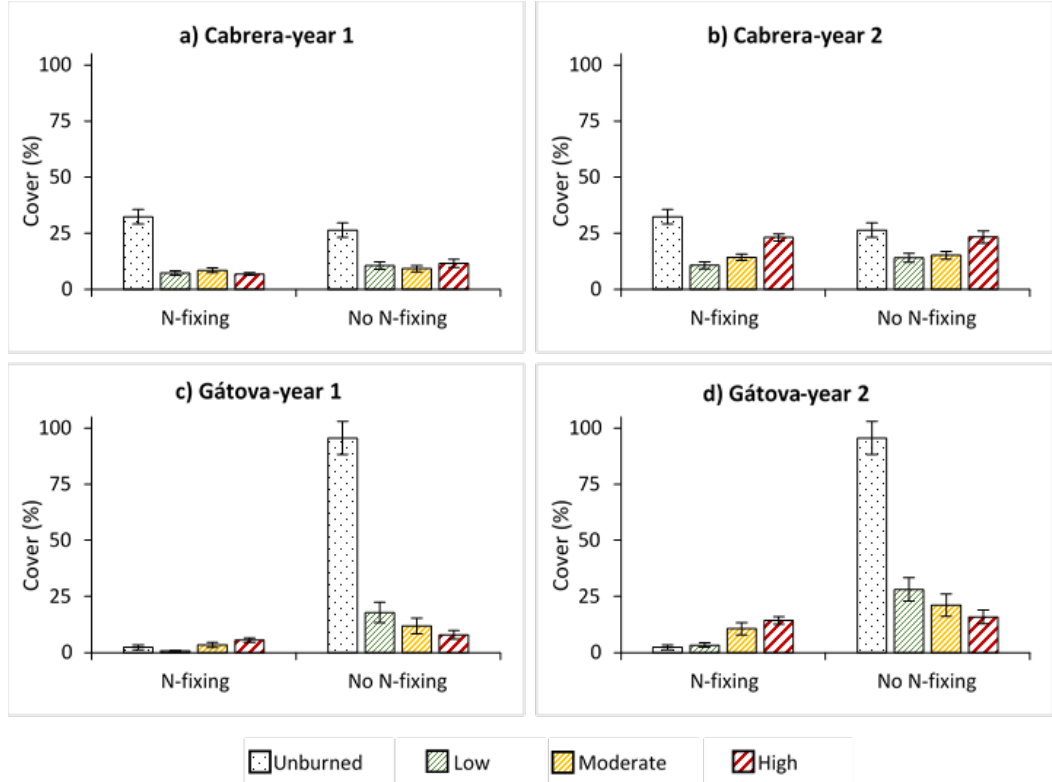
Figure 3. Average cover (%) of species with N 2 -fixing and no N 2 -fixing capacity, and standard error for each burn severity level (unburned, low, moderate, and high) measured by the composite burn index (CBI) in: ( a ) Cabrera, one year post-fire; ( b ) Cabrera, two years post-fire; ( c ) Gátova, one year post-fire; and ( d ) Gátova, two years post-fire. Statistical information is provided in Tables S3 and S4 (Supplementary Material).